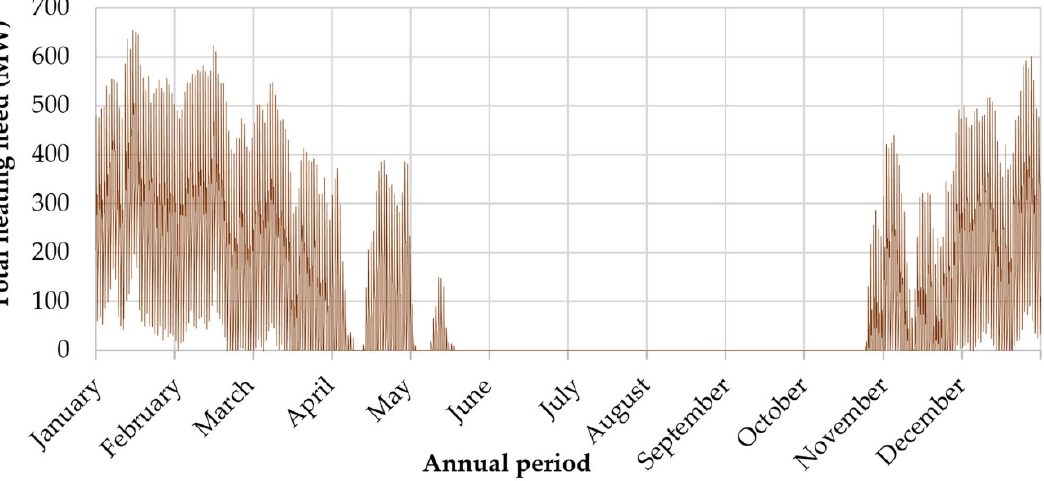
Figure 15. Annual fluctuation in the total heating needs in the residential buildings of the 12 biggest cities and towns in Crete Island, Greece.